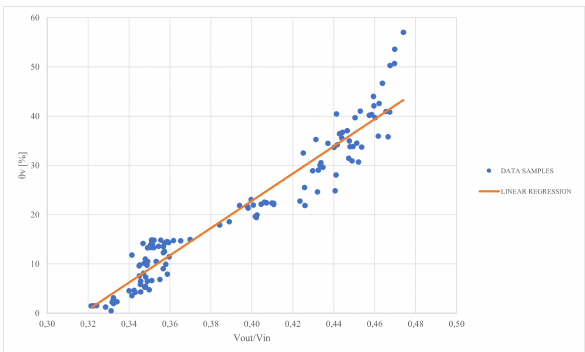
Figure 5. Laboratory sensors calibration